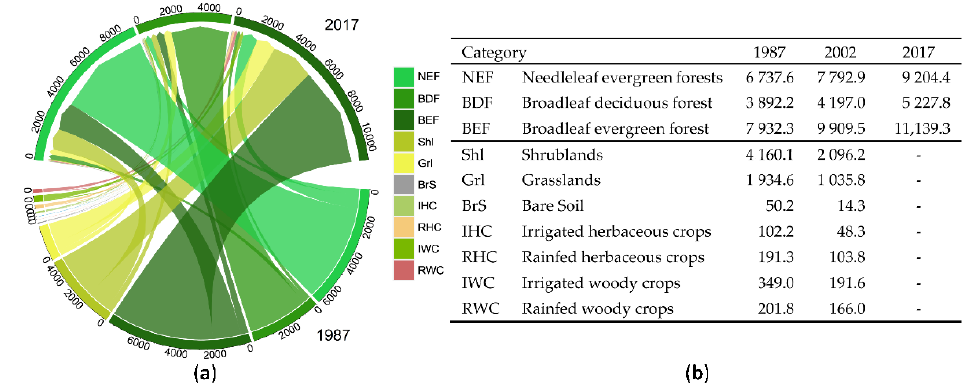
Figure 3. ( a ) Chord diagram showing NF trajectories between 1987 and 2017 in the whole transect. ( b ) Table detailing the occupation of each category implied in NF consolidated trajectories. All figures are shown in km 2 .